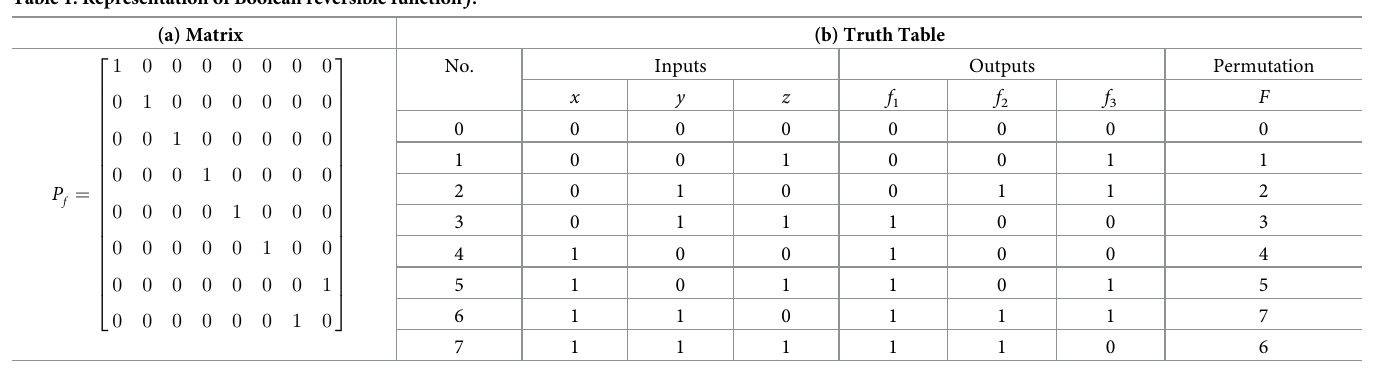
(a) Matrix form representation of the given Boolean reversible function f (b) Truth table form representation of the given Boolean reversible function f